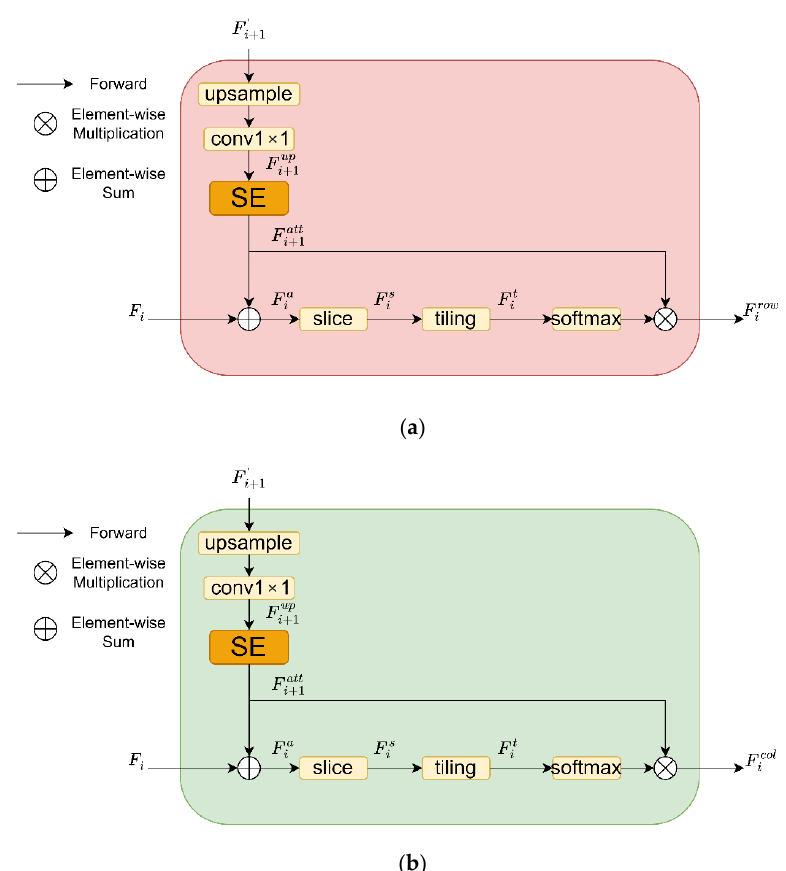
Figure 5. RAA module and CAA module ( a ) RAA module; ( b ) CAA module. As shown in Figure 4. All input images are normalized and then passed into the model. After a 3 × 3 convolutional layer, four outputs are obtained through the Maxpool layer, stage2 layer, stage3 layer, and stage4 layer as the input of the RAA module and the CAA module.